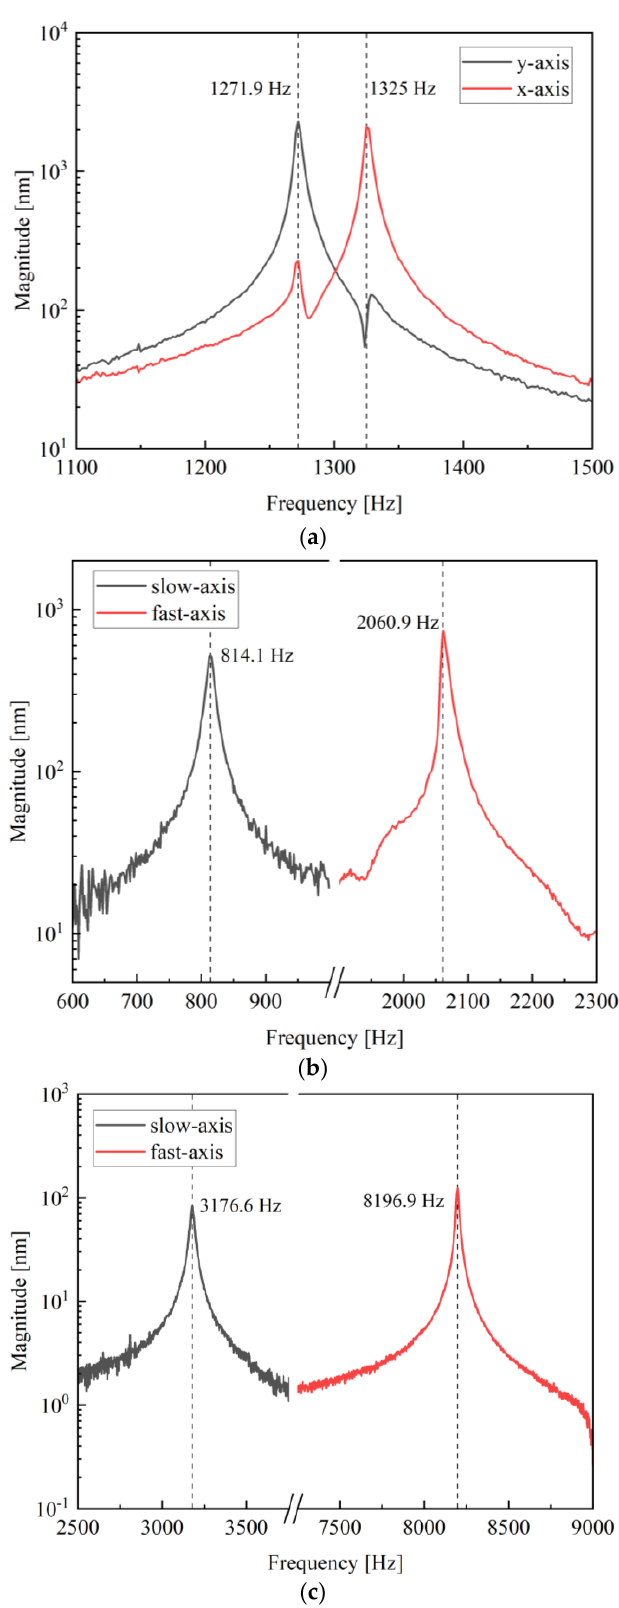
Figure 7. Resonance spectrum of ( a ) Mirror I-1, ( b ) Mirror II-1 and ( c ) Mirror II-2 for two perpendicular axes.